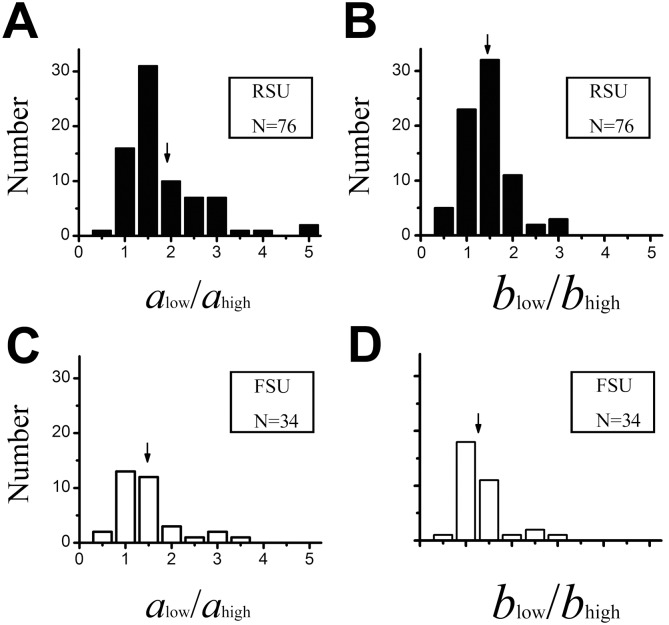
Histograms of contrast-dependent variations in the excitatory and inhibitory spatial spread for RSUs and FSUs.The ratio alow/ahigh was used to describe the enlargement in the extent of CRF and blow/bhigh for nCRF. The solid and hollow columns represent RSUs and FSUs, respectively. The arrows indicate the average in each subgraph.